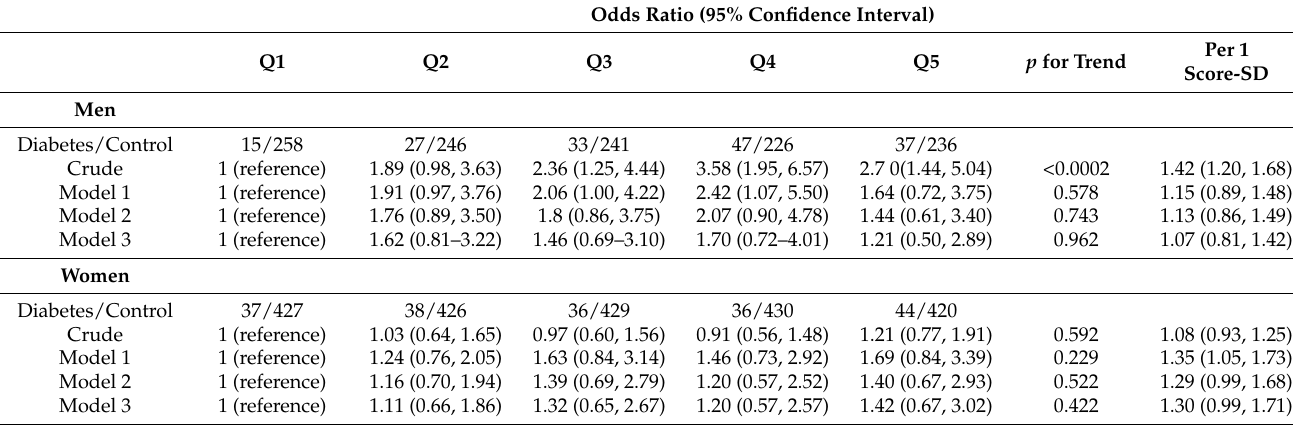
Table 6. Associations of the biomarker-related and RRR-derived dietary pattern scores with type 2 diabetes among males and females 1 . Odds Ratio (95% Confidence